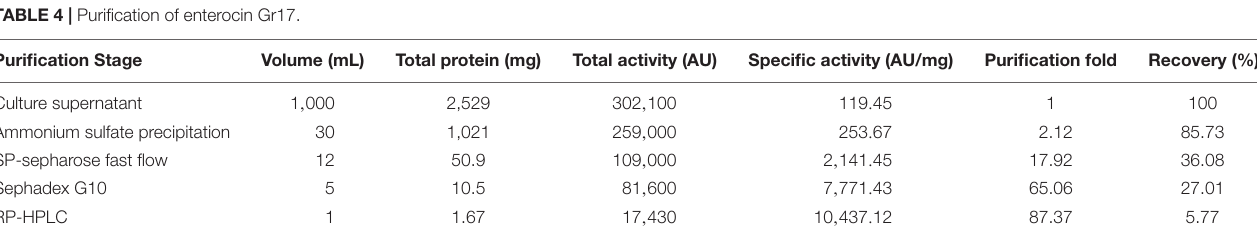
TABLE 4 | Purification of enterocin